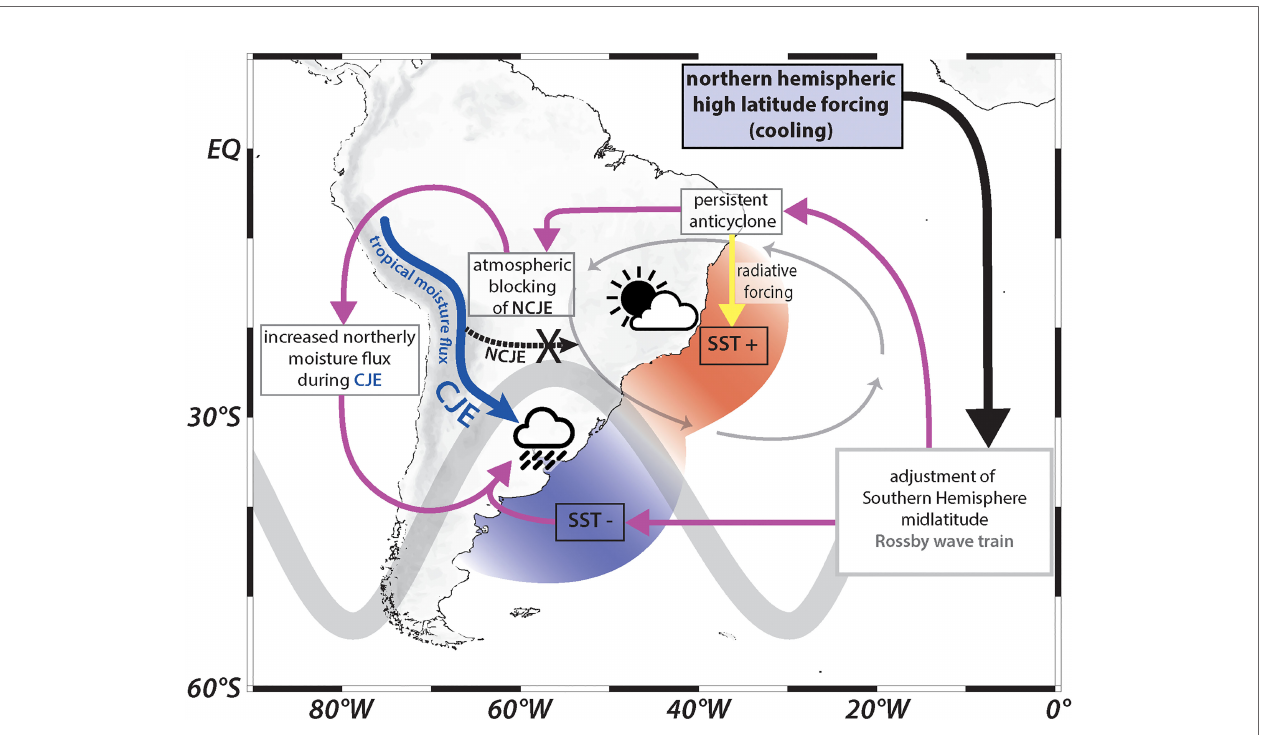
FIGURE 2 | Schematic representation of the mechanism active during the negative SALLJ/SACZ dipole phase in South America and the western South. Northern hemispheric cooling (in line with a southward shift of the ITCZ into the warmer Southern Hemisphere) triggers the adjustment of the Southern Hemisphere mid- latitude Rossby wave train (thick grey line). In turn, a persistent anticyclone (grey ellipse) establishes over eastern and southeastern Brazil. Increased radiative forcing (yellow arrow) leads to increased sea surface temperatures (SST) in the tropical western South Atlantic. The persistent anticyclone blocks the easterly fl ow of the SALLJ during its “ non Chaco Jet Event ” (NCJE) con fi guration (black dotted arrow) and prohibits tropical moisture fl ux towards southeastern South America (SESA). This results in dryer conditions across SESA. Tropical moisture is rather channeled by the SALLJ towards subtropical southern Southeastern South America during the “ Chaco Jet Event ” (CJE) (thick blue arrow), wich signi fi cantly increases rainfall in its exit